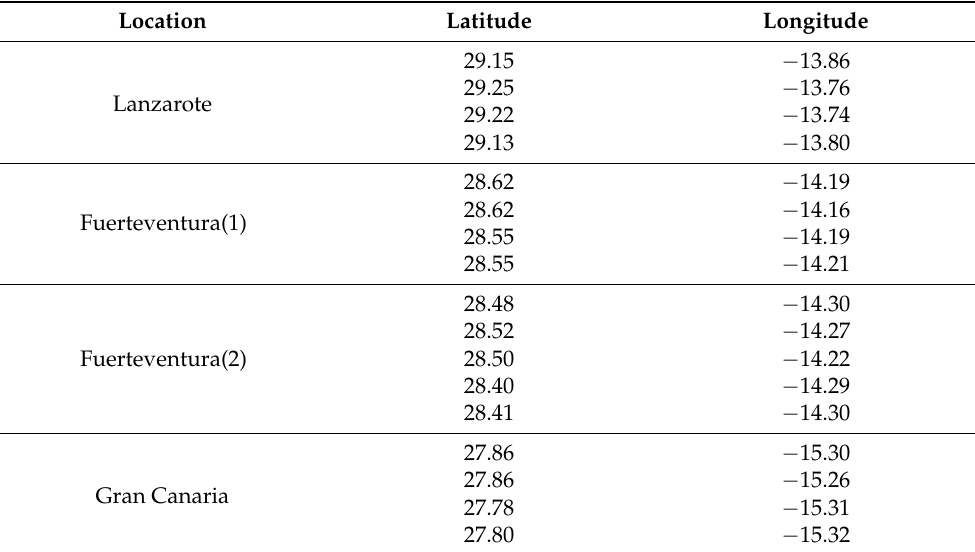
Table 4. Geographic coordinates (WGS84) for all the corners of the four proposed locations. Location